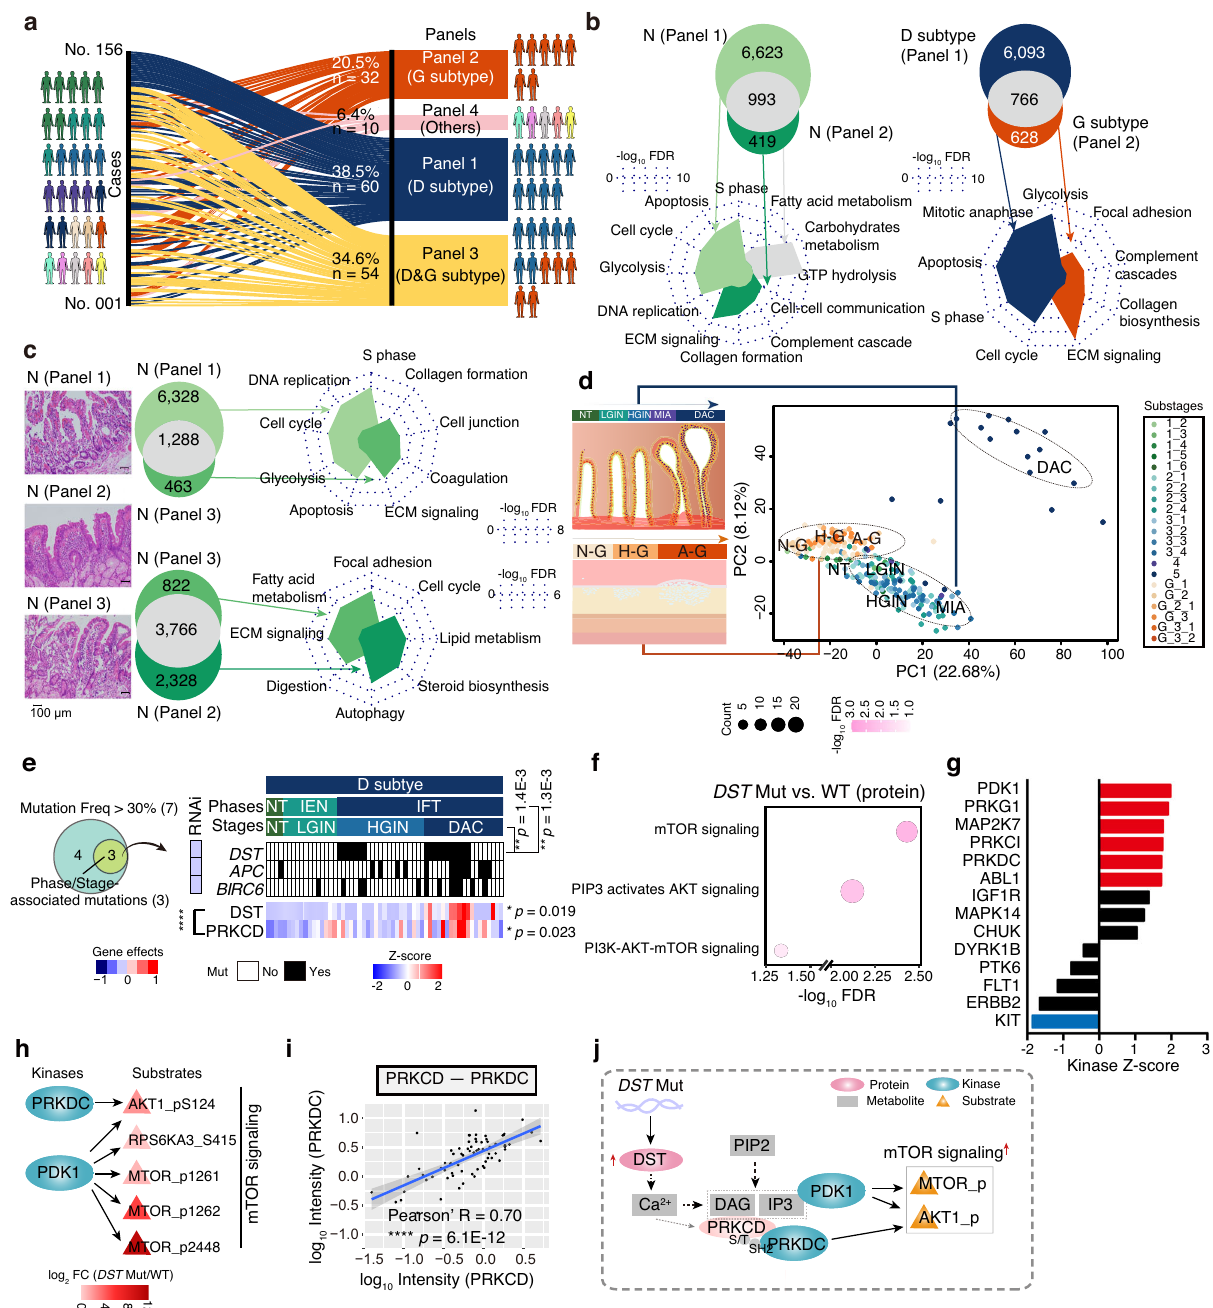
Fig. 4 | The diverse characteristic origins and the staging waves in the pro- gression of the D and G subtypes. a Sankey diagram analysis of all the 156 cases classi fi ed into 4 panels. b Venn diagram depicting the speci fi c driven pathways in thenormal(left)andtumor(right)tissuesoftheP1andP2.Thegreenhighlightsthe normal tissue. The blue and orange indicate the D and G subtypes, respectively. c Themorphologicalfeature(H&Estaining)(left)andrepresentedpathways(right) ofnormaltissue(stage1)amongtheP1 – P3. d PCAoftheDandGsubtypessamples. e Venndiagram(left)showingthephase/stageassociatedmutationsintheDandG subtypes(two-sidedFisher ’ sexacttest)andheatmap(right)displayingtheimpacts of DST mutation on the protein-levels of DST and PRKCD (two-sided Wilcoxon